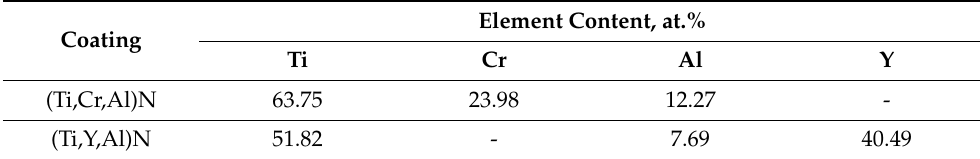
Table 2. Compositions of the coatings under